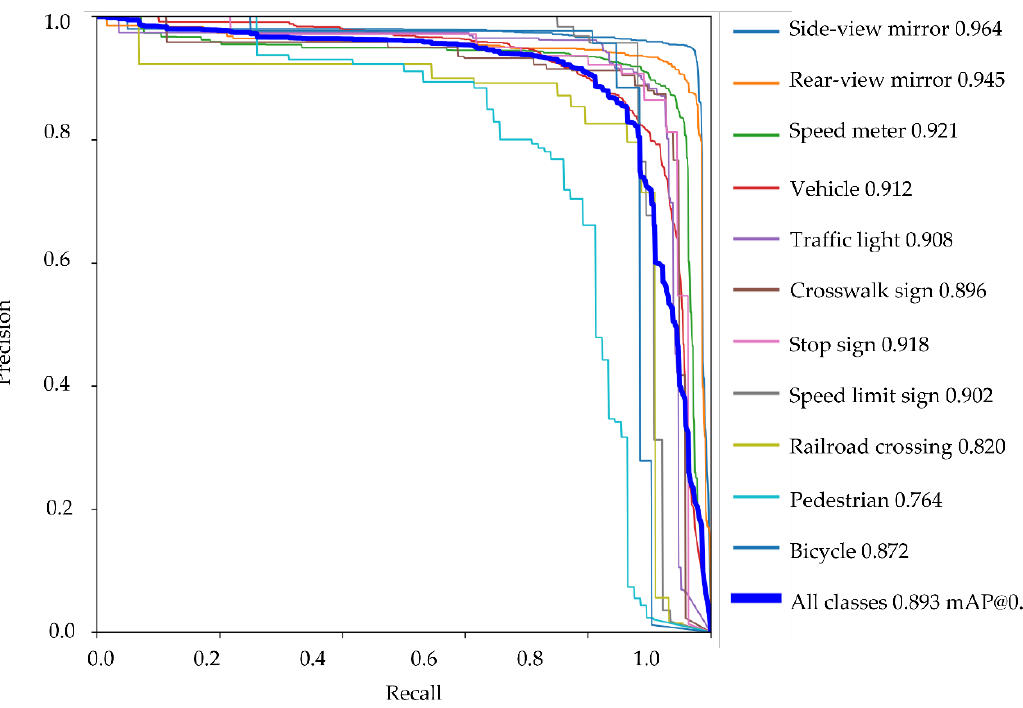
Figure 4. The result of object detection is shown by a PR curve(mAP@0.5).